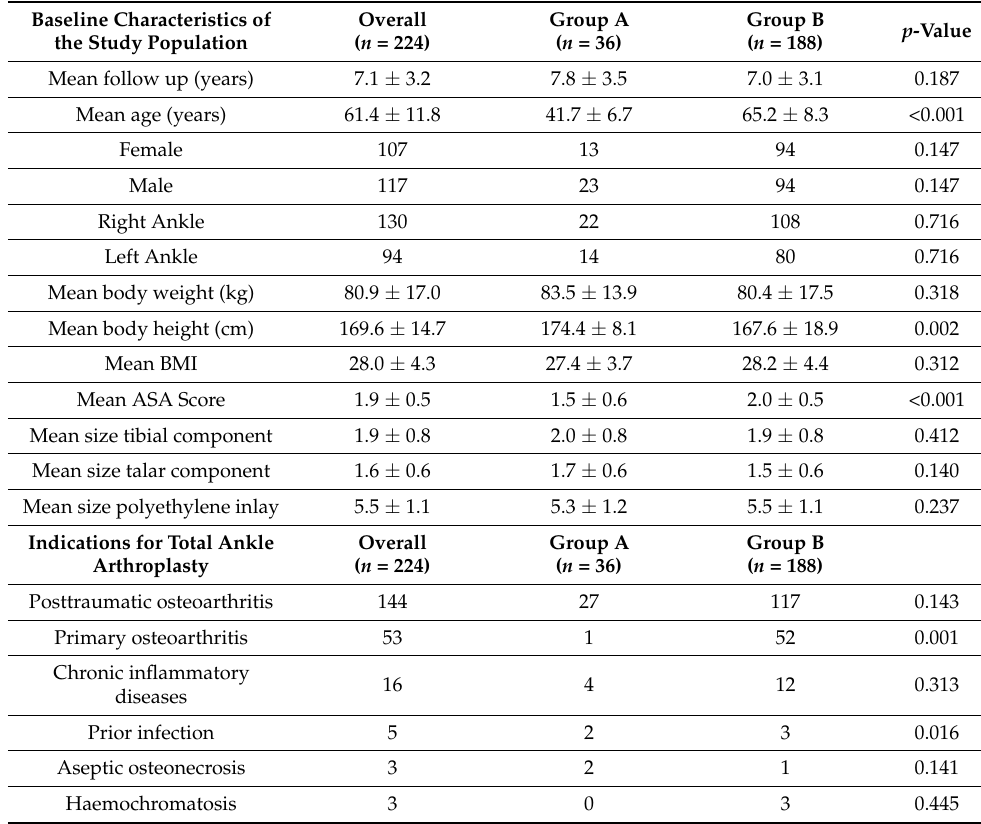
Table 1. Baseline characteristics of the two study groups including the indications for